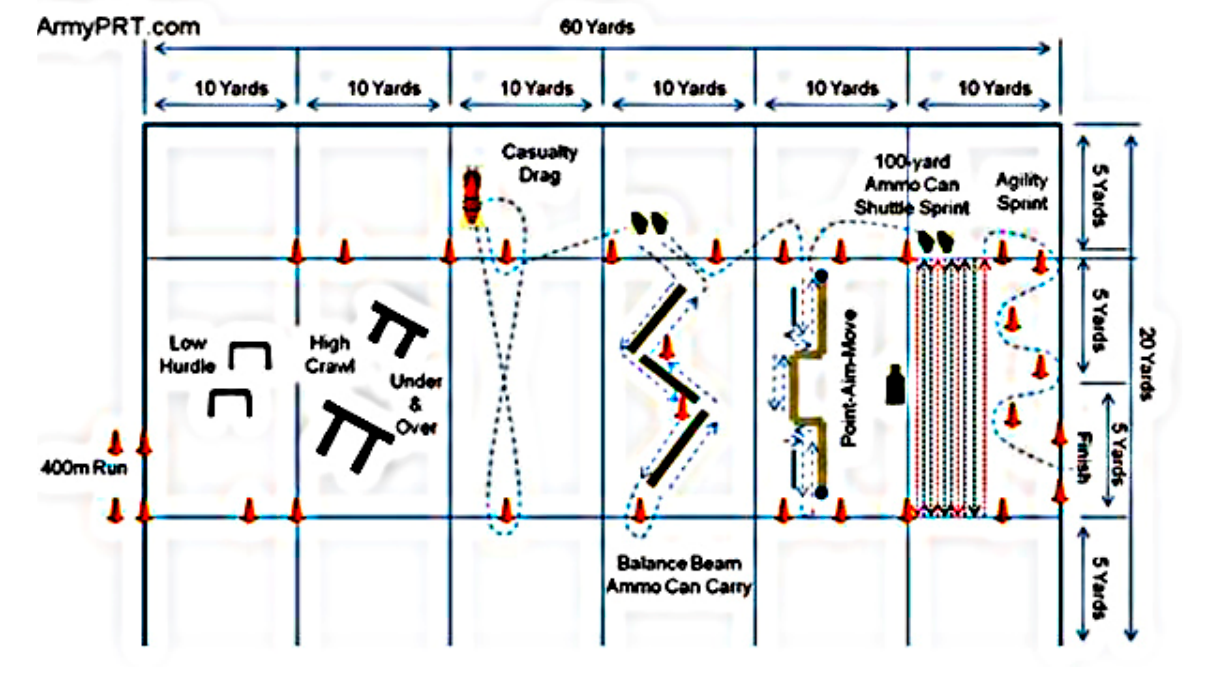
Figure 1. ACRT test steps.